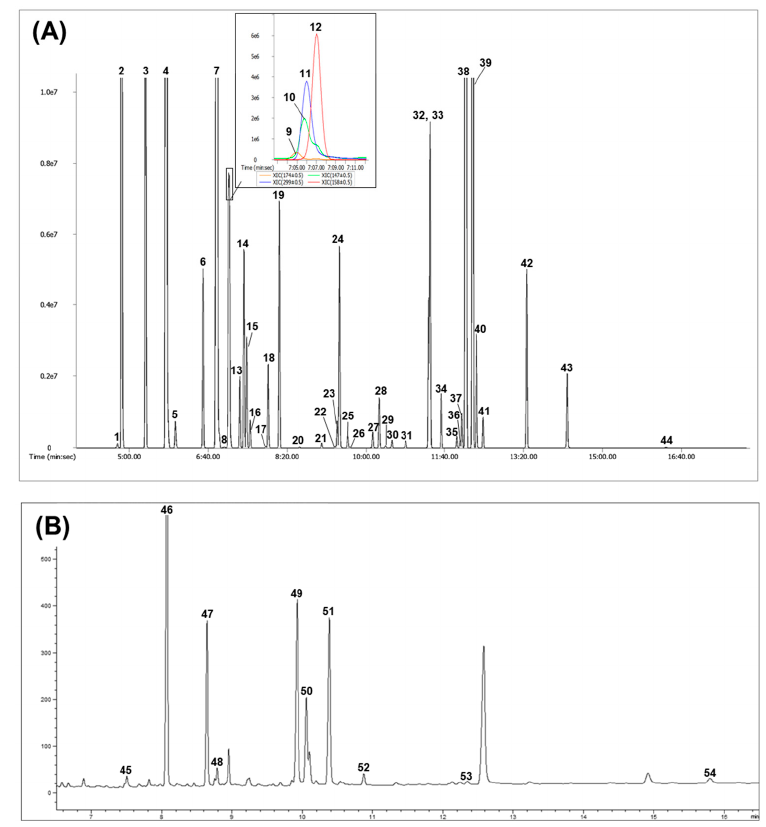
Figure 1. Representative gas chromatography time-of-flight mass spectrometry (GC-TOF MS) hydrophilic compounds ( A ), and GC-flame ionisation detection (GC-FID) fatty acids ( B ) chromatograms obtained from the serum of beagle dogs fed BG-H for 8 weeks. BG-H, a regular diet with high concentration of BG extract. Fatty acid formula is: C (number of carbon atoms): (number of double bonds) nx (position of double bonds). Peak: 1, pyruvic acid; 2, lactic acid; 3, alanine; 4, oxalic acid; 5, glycolic acid; 6, valine; 7, urea; 8, serine-1; 9, ethanolamine; 10, phosphoric acid; 11,